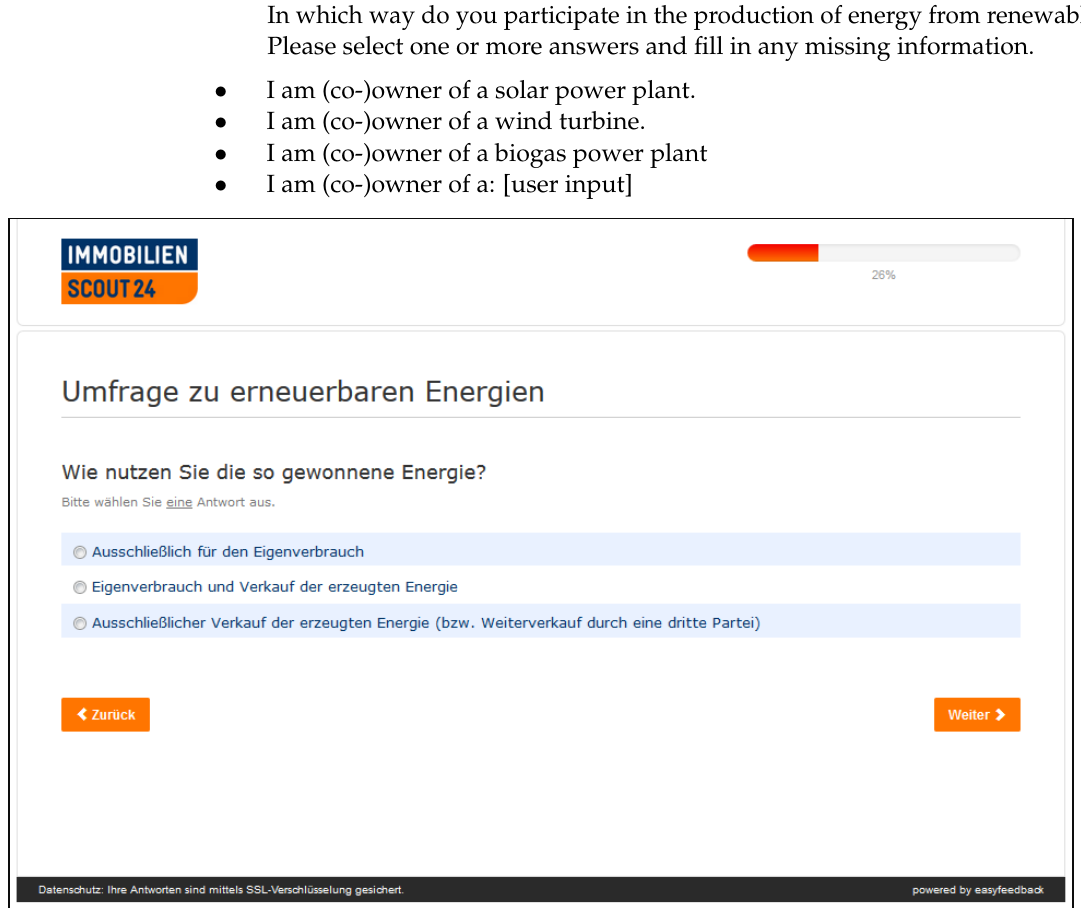
Figure A7. Screenshot of Questionnaire Page 6.